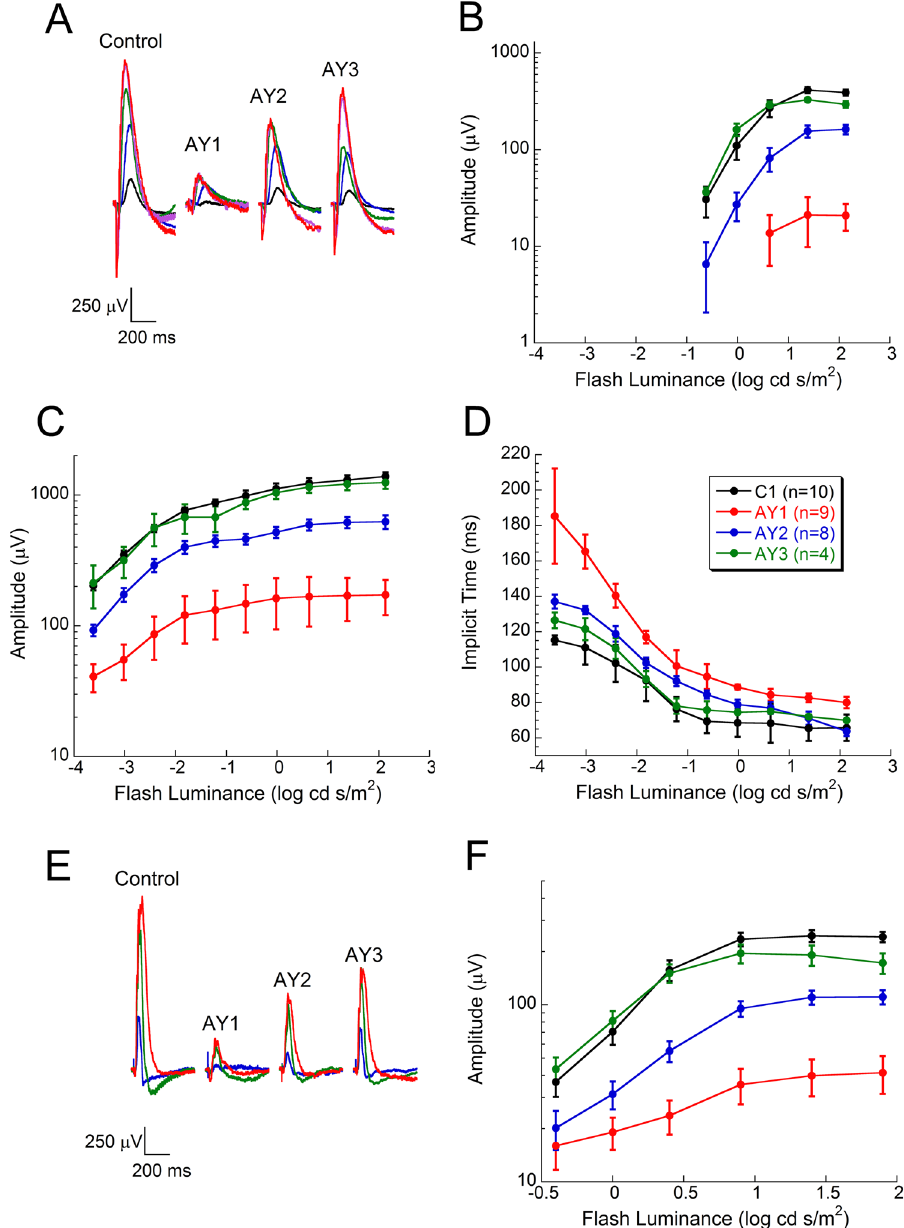
Figure 3. Electroretinographic analysis of control vs . AY9944-treated rats as a function of diet. ( A ) Representative dark-adapted ERG waveforms from a member of each experimental group. Flash strength is color-coded: ( black : − 3.6 log cd s/m 2 ; blue : − 2.4 log cd s/m 2 ; green : − 1.2 log cd s/m 2 ; red : 0.0 log cd s/m 2 ; red : 1.4 log cd s/m 2 ). Summary plots are shown for ( B ) the amplitude of the ERG a-wave and ( C ) b-wave, and ( D ) the implicit time of the ERG b-wave. ( E ) Representative light-adapted cone ERG waveforms from a member of each experimental group. Flash strength is color-coded: ( blue : 0.0 log cd s/m 2 ; green : 0.9 log cd s/m 2 ; red : 1.9 log cd s/m 2 ). ( F ) Summary plots for the amplitude of the cone ERG. Data points are mean ± S.E.M. values, for n biological replicates, obtained from rats at age PN 80–82 days at time of ERG measurements: C1 group, n = 10; AY1 group, n = 9; AY2 group, n = 8; AY3 group, n = 4 (see inset, panel D, for color key). Note the overlap in data points for ERG responses from C1 and AY3 group animals. [See Results for presentation of statistical analysis of